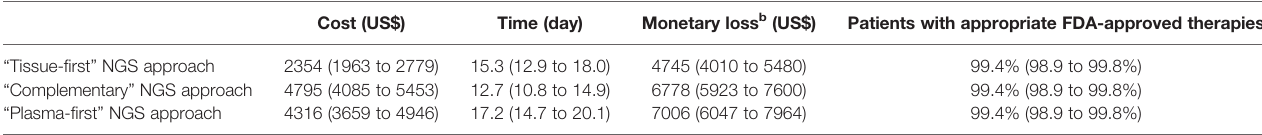
TABLE 2 | Base-case results a